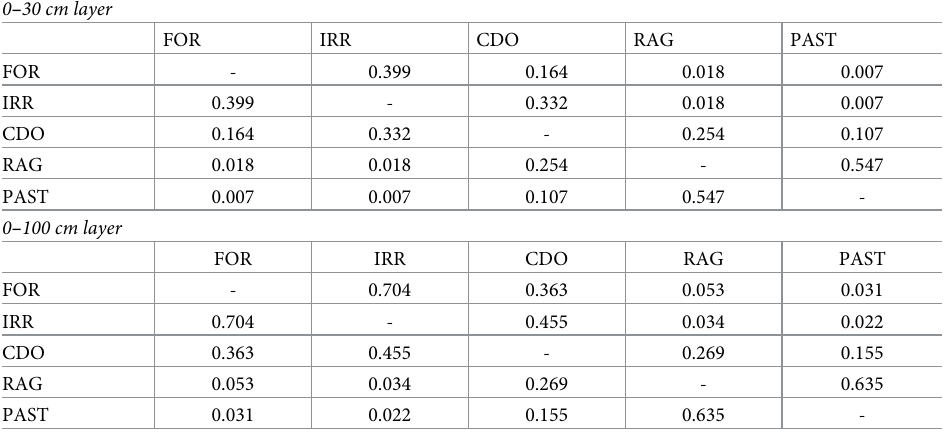
Table 5. p -values obtained by Student’s t-test with α = 0.05 for differences in the means between soil carbon values of agricultural LUs and native vegetation LCs in Western Bahia for 0–30 cm and 0–100 cm